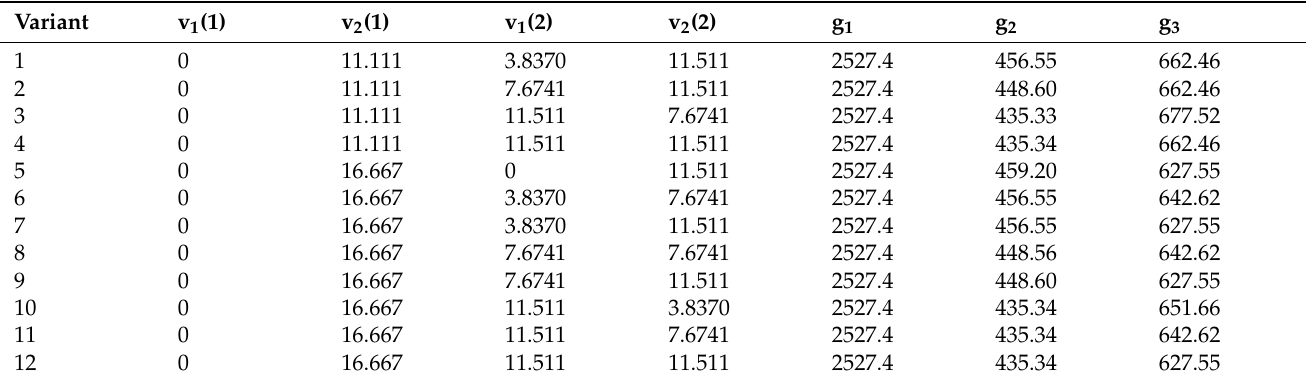
Table 1. Undominated strategies of the influence agents under fixed Principal’s strategy r 1 (1) = 0,